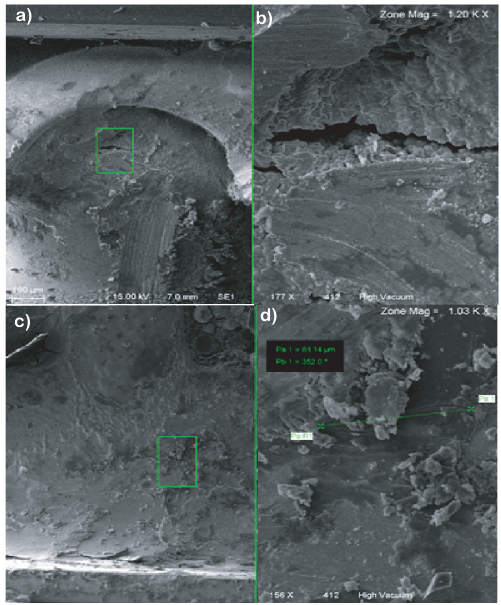
Figure 6. Fracture in the soldering alloy